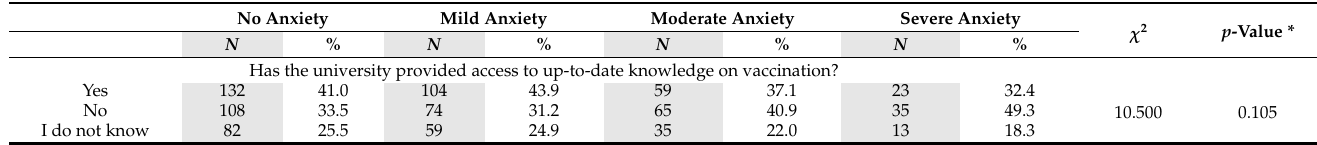
Table 3. Anxiety level and access to current information on vaccination at university.